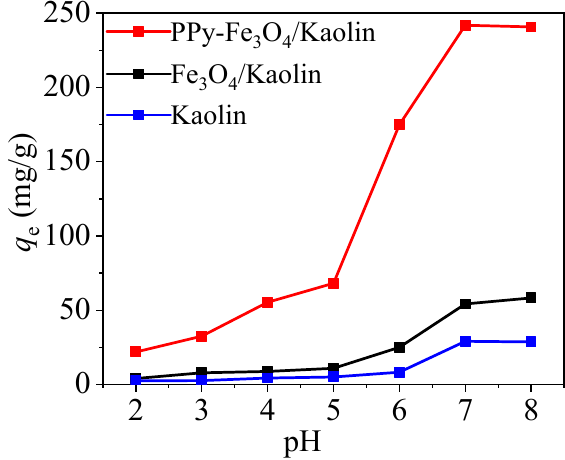
Figure 8. Influence of pH with Kaolin, Fe 3 O 4 /Kaolin, and PPy-Fe 3 O 4 /Kaolin.